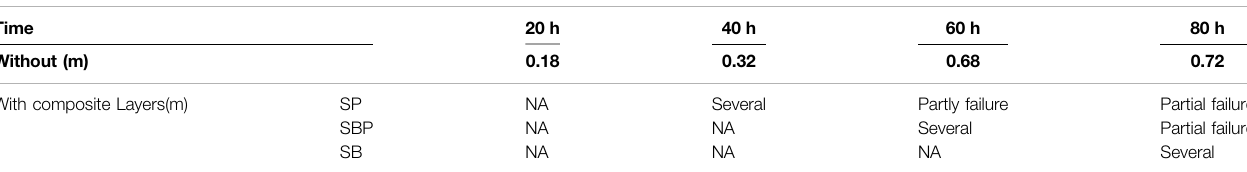
TABLE 11 | Damage depth of subgrade slopes with and without composite protection